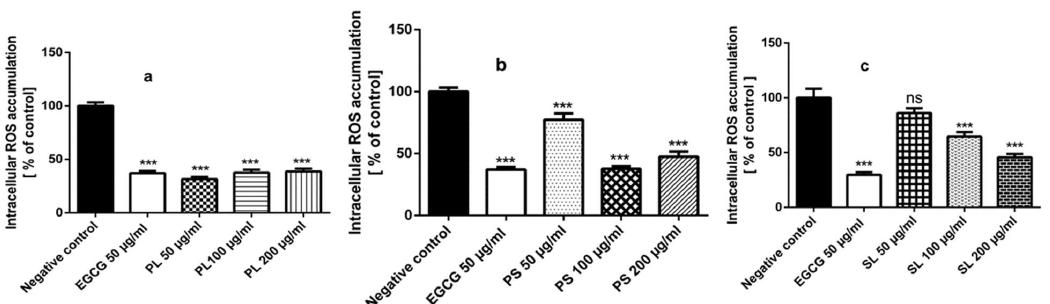
Figure 4. Influence of EGCG (epigallocatechin gallate) and the extracts of PL ( P. alba leaf), PS ( P. alba shoots) and SL ( S. subserrata leaf) on intracellular ROS (reactive oxygen species) production in N2 worms, evidenced by the indicator H 2 DCF-DA. (a) PL significantly reduced ROS accumulation to 31.51%, 37.54% and 38.75% after pre-treatment with 50, 100 and 200 µg/mL, respectively. (b) PS treated N2 worms showed significant reduction in ROS level to 77.26%, 37.63% and 47.42% after pre-treatment with 50, 100 and 200 µg/mL, respectively. (c) ROS production was significantly reduced to 64.35% and 45.57% after pre-treatment with 100 and 200 µg/mL SL, respectively. The results are expressed as mean ± SEM from three independent experiments. Results are expressed as the percentage of fluorescence pixel intensity related to untreated control (100%). Statistical significance of difference between untreated control (negative control) and treated groups was analyzed by one-way analysis of variance followed by Bonferroni (post hoc) (ns (not significant) p > 0.05, *** p < 0.0001).